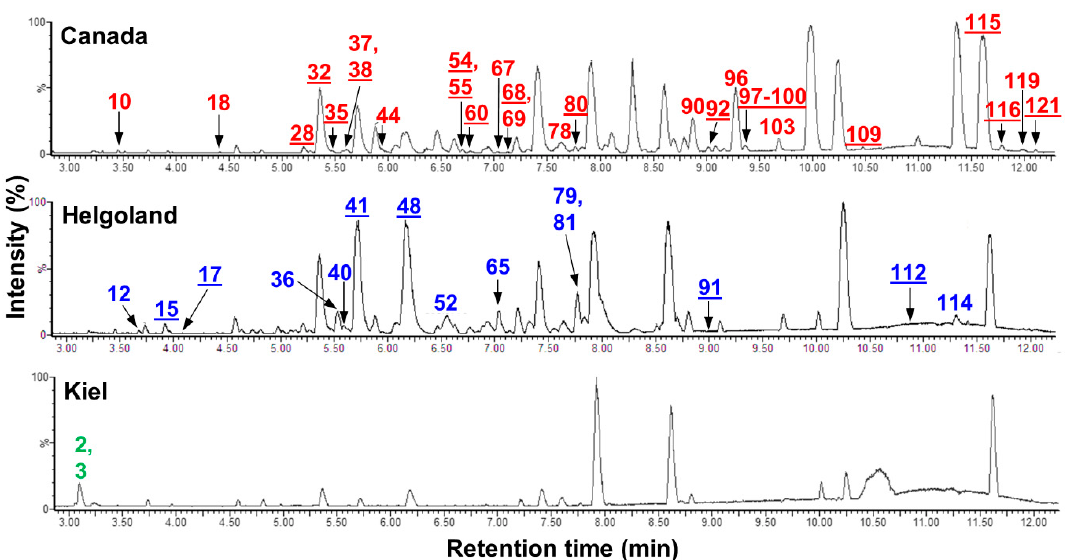
Figure 5. UPLC-MS chromatograms of C. intestinalis extracts from different sampling sites. For each sampling site, one representative extract was selected (Canada: C1, Helgoland: H2, Kiel: K2). Metabolites with enhanced or exclusive (underlined numbers) production in one of the three sampling locations are labelled with the respective peak number. Peak annotation is in accordance with Table S11 and annotated peaks were color-coded reflecting their sampling location (red: Canada, blue: Helgoland, green: Kiel).